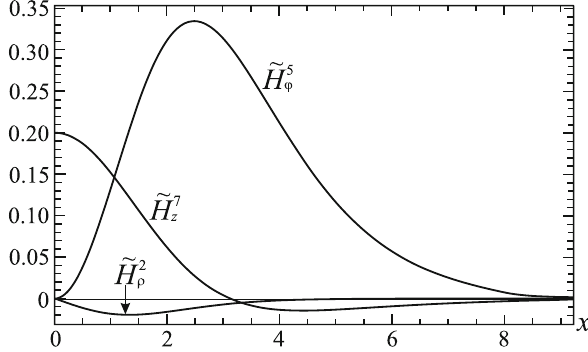
Fig. 4 The profiles of the color magnetic fields ˜ H 2 ρ ≡ gH 2 ρ /φ 2 ( 0 ), ˜ H 5 ϕ ≡ gH 5 ϕ /φ( 0 ) , and ˜ H 7 z ≡ gH 7 z /φ 2 ( 0